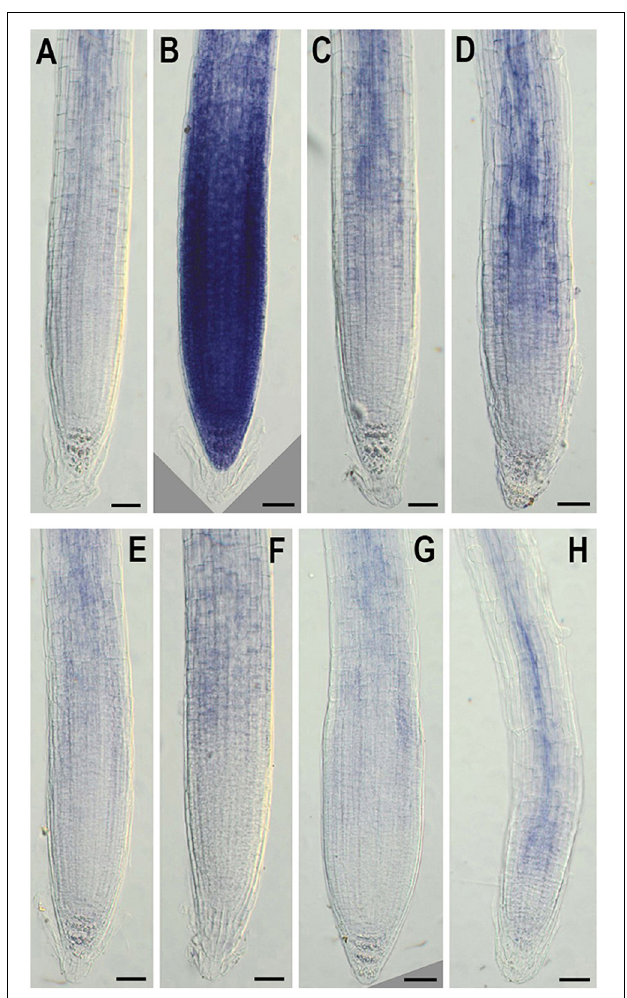
FIGURE 8 | In situ detection of H 2 O 2 by 3,3-diaminobenzidine (DAB) staining in 6-day-old wild-type (A–D) and NMig1 -overexpressing (E–H) seedlings under optimal growth conditions (A,E) , and after exposure to heat shock (B,F) , drought (C,G) , and high salinity (D,H) . Representative images from three independent experiments are shown. Scale bars = 50 µ